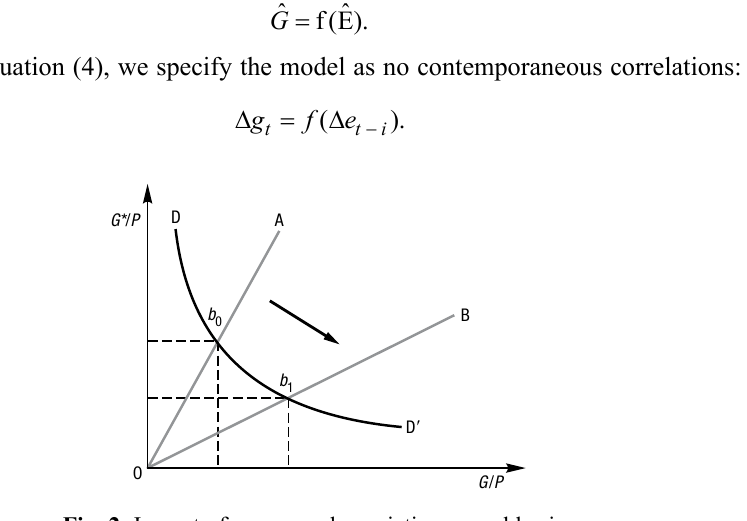
Fig. 2. Impact of currency depreciation on gold